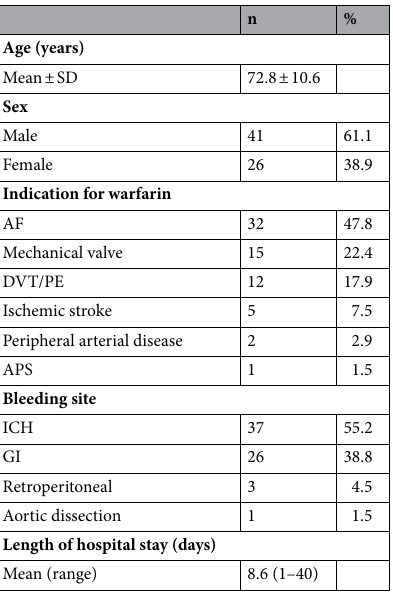
Table 1. Patient characteristics. APS antiphospholipid syndrome , DVT deep venous thrombosis, GI gastrointestinal , ICH intracerebral hemorrhage , PE pulmonary embolism.